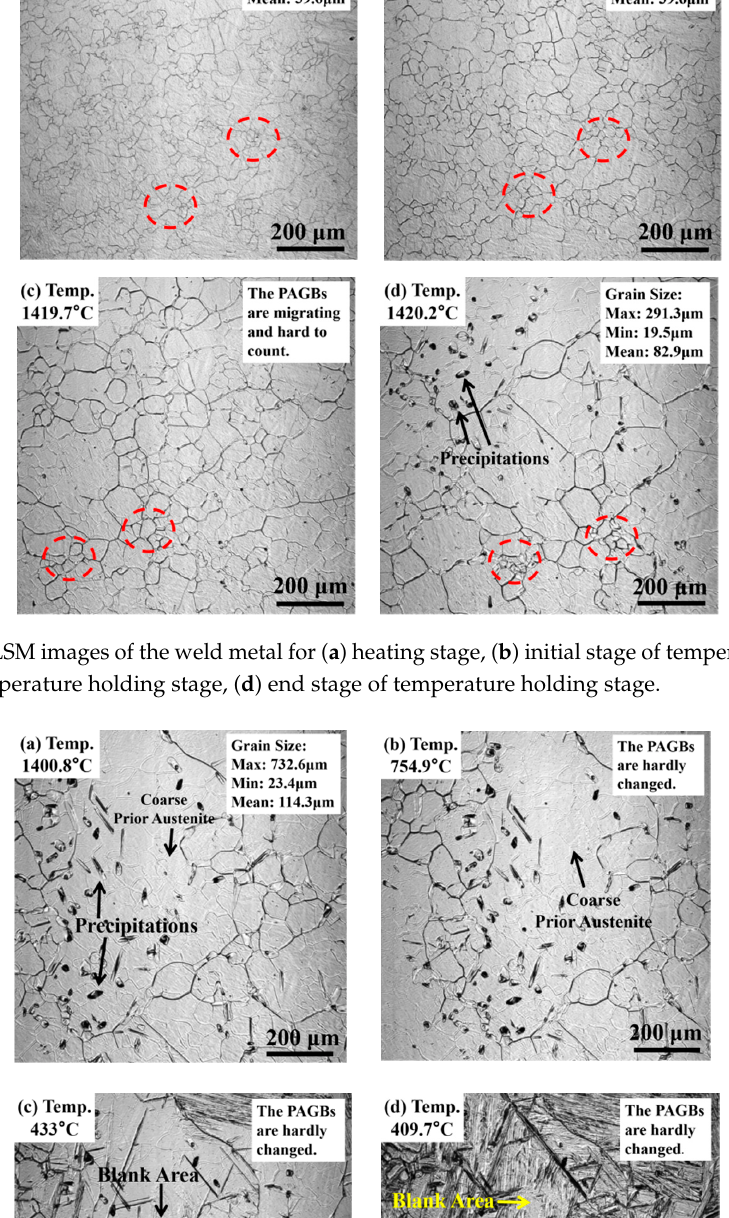
Figure 11. CLSM images of the weld metal for ( a ) heating stage, ( b ) initial stage of temperature holding stage, ( c ) temperature holding stage, ( d ) end stage of temperature holding stage.